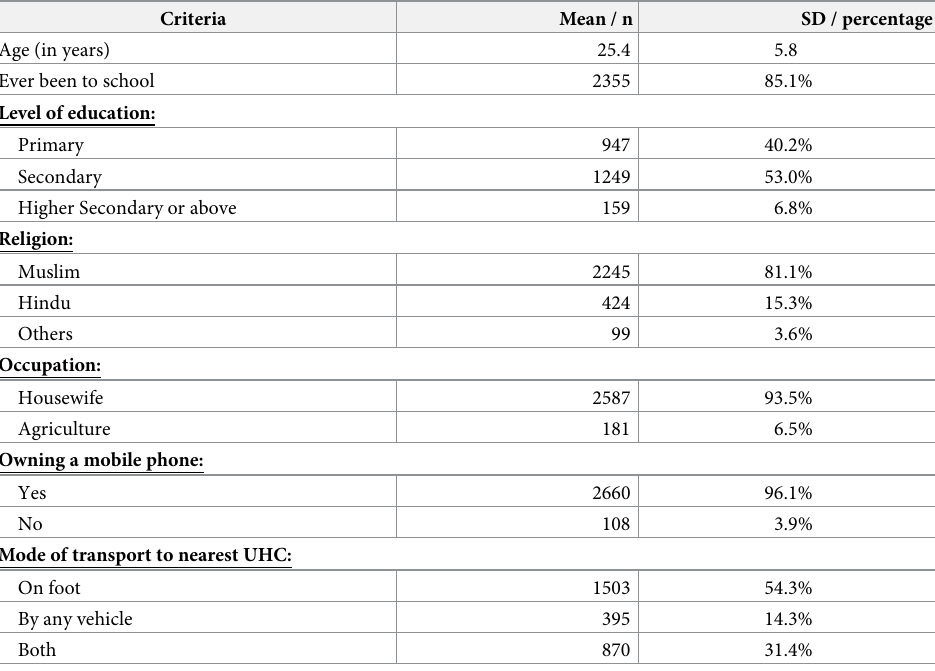
Table 2. Sociodemographic characteristics of the study participants [N = 2,768].